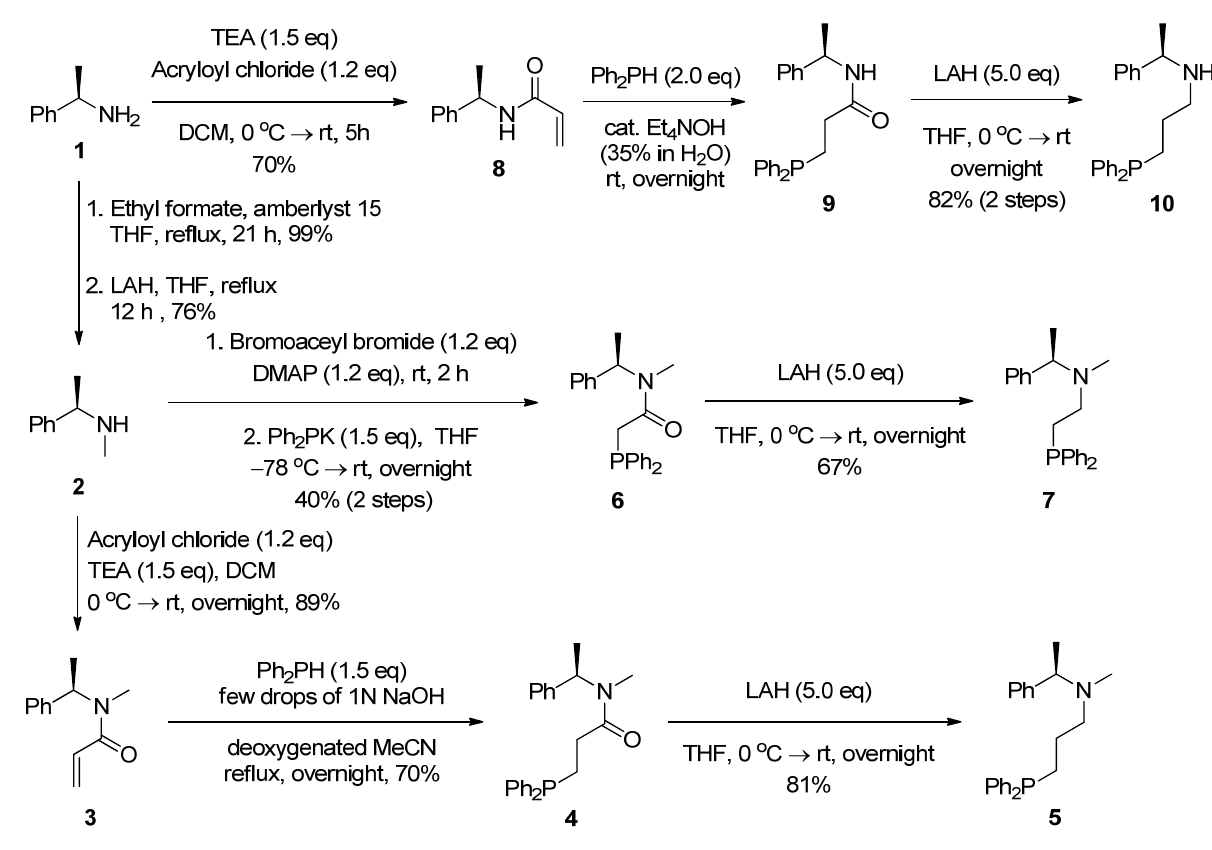
Table 2. Screening with synthetic chiral aminophosphines and